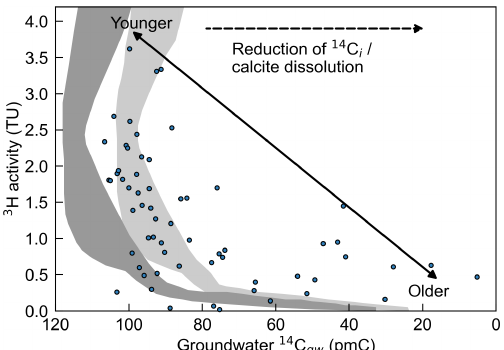
Figure 5. Comparisons between measured 3 H and 14 C gw activities and MRTs for the Ovens/Goulburn–Broken catchments (see Fig. 2). Note that the x axis ( 14 C gw ) has been inverted. Grey shading de- notes the predicted covariation of 3 H and 14 C for the case where no macroscopic mixing between old and young groundwater has oc- curred, dark grey for q = 1 and light grey for q = 0.85. Dark grey shaded region from Cartwright et al.